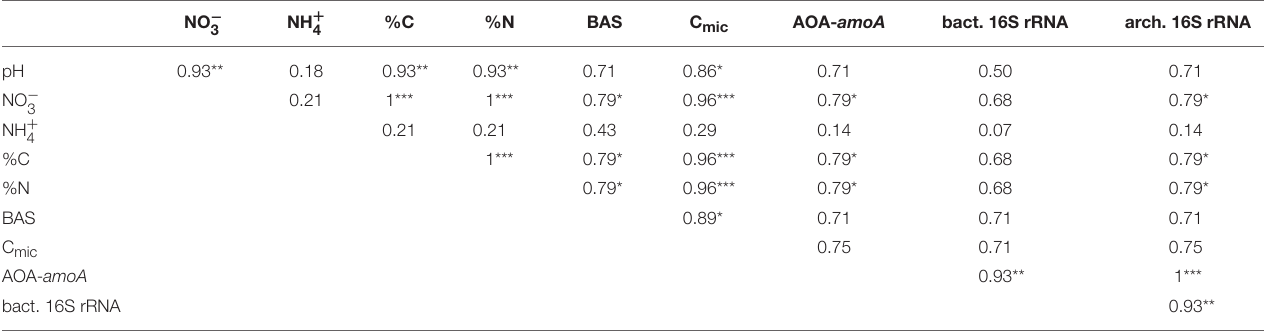
TABLE 2 | Correlations (Spearman’s rank correlation coefficients) between abundances of archaeal amoA (AOA -amoA ), archaeal and bacterial 16S rRNA genes, soil chemical parameters (soil pH, ammonium and nitrate concentrations, total C and N content) and respiration-based parameters (BAS, basal respiration; C mic , microbial biomass) along the granitic and basaltic